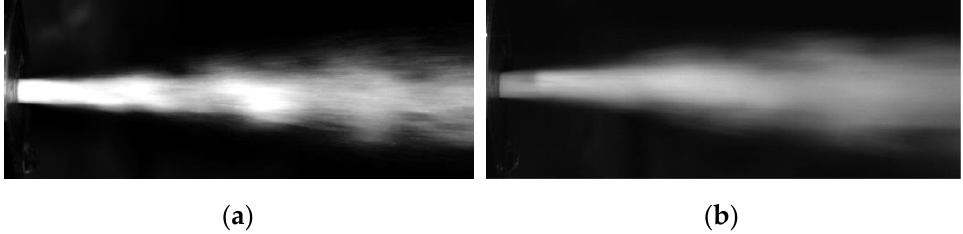
Figure 12. Images of the formation of hydrodynamic pulses during the operation of the head in the